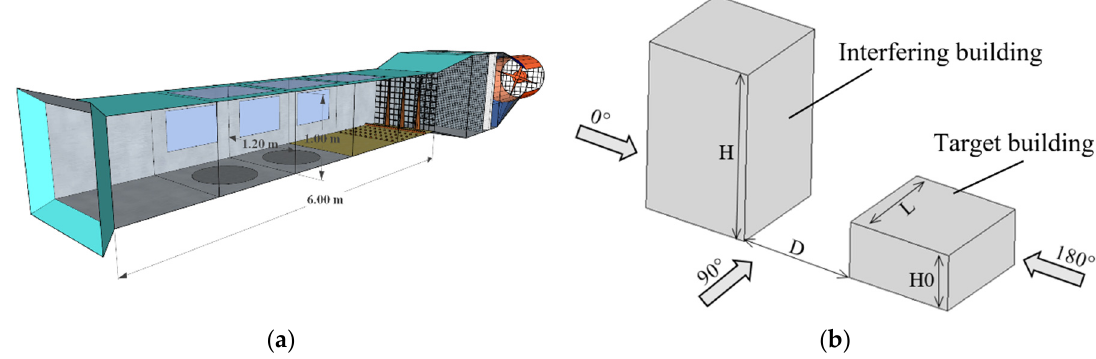
Figure 2. Schematic diagram of the wind tunnel tests: ( a ) wind tunnel diagram; ( b ) building configuration.